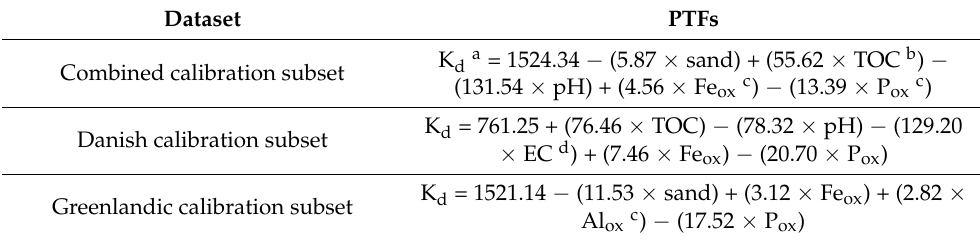
Table A3. Pedotransfer functions to predict the K d (L kg − 1 ) of glyphosate for all the calibration subsets.